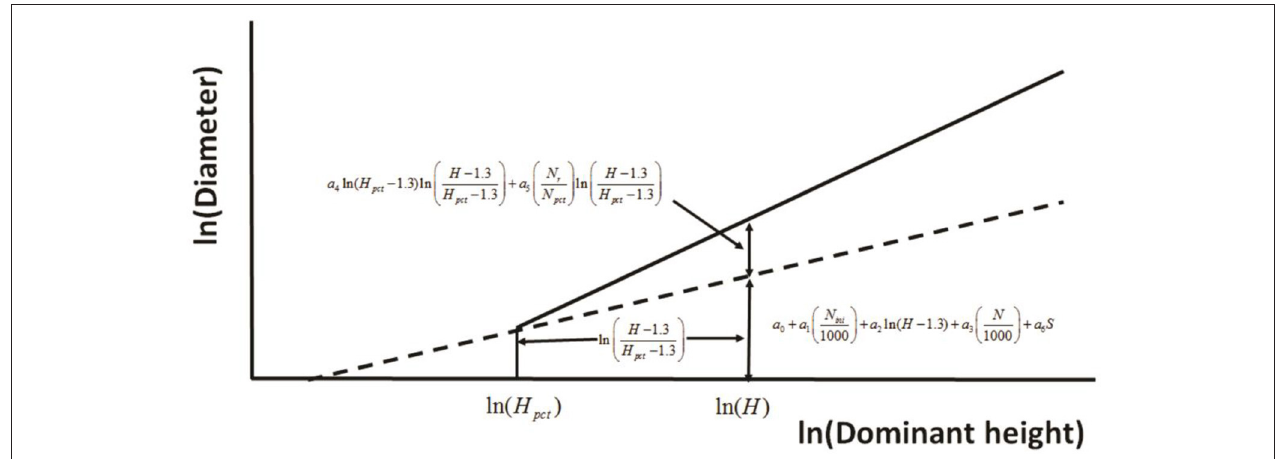
FIGURE 4 | The principle used in defining the effect of precommercial thinning on the diameter development at a logarithmic scale (redrawn from Huuskonen and Hynynen,